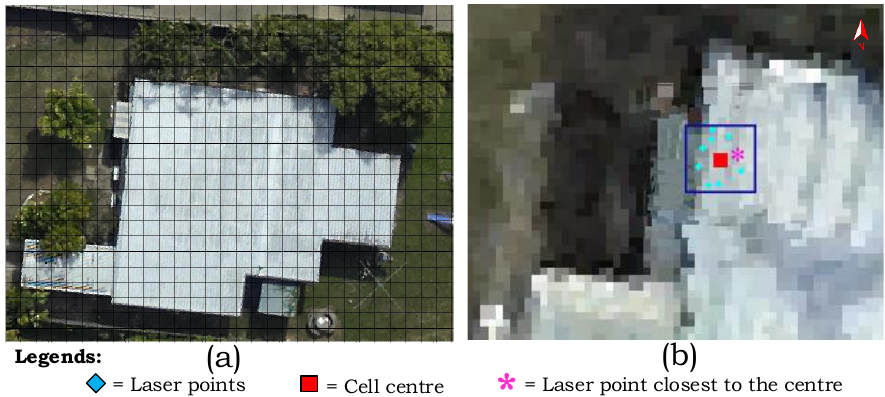
= Laser points = Cell centre = Laser point closest to the centre * Figure 4. ( a ) Grids overlaid on a sample image; ( b ) LiDAR points within a grid cell.